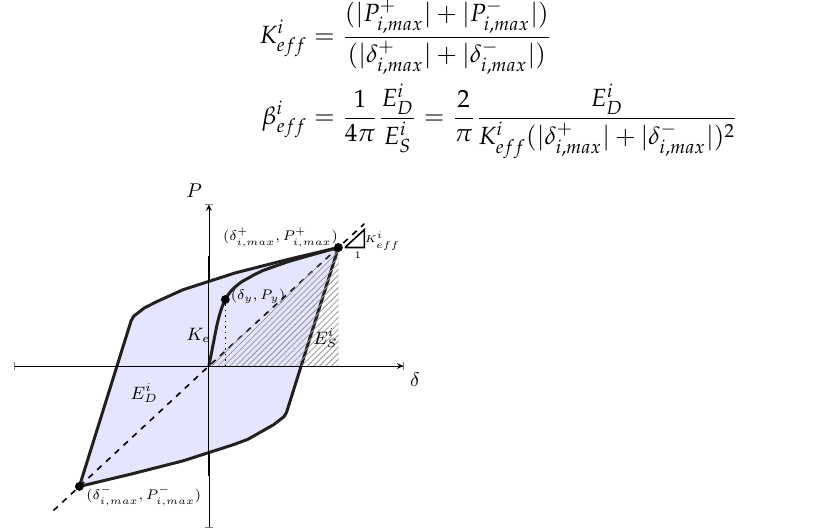
Figure 8. Parameters of a damper from the hysteresis